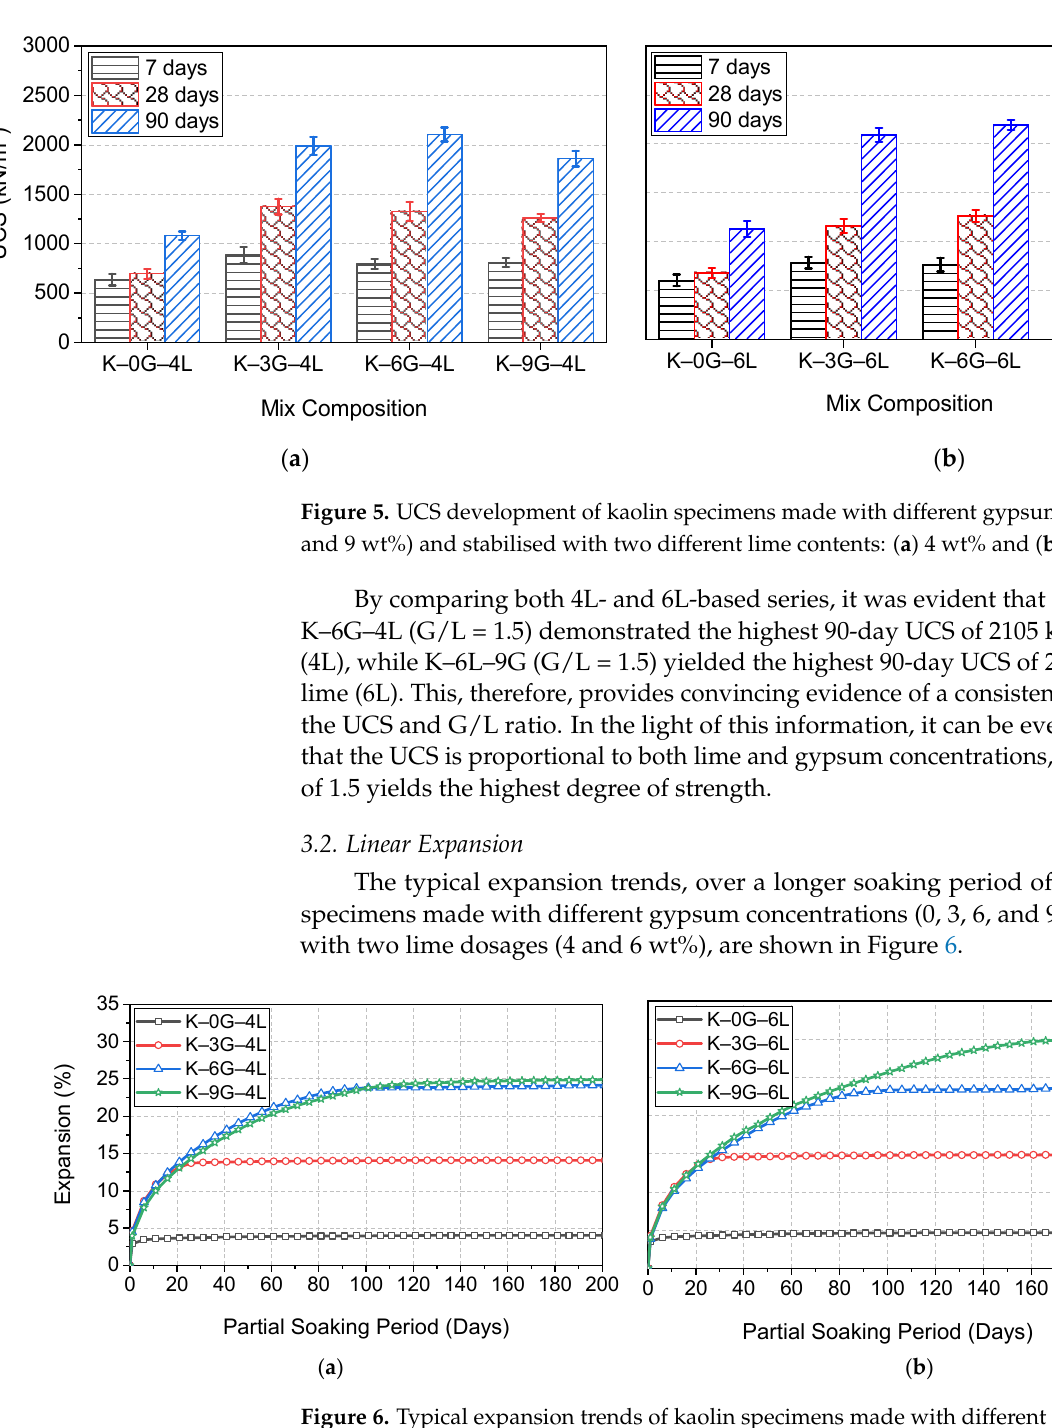
Figure 6. Typical expansion trends of kaolin specimens made with different gypsum concentrations (0, 3, 6, and 9 wt%) and stabilised with two different lime contents: ( a ) 4 wt% and ( b ) 6 wt%. Like the case of UCS, it was observed that the control formulations (without gypsum) tended to show the lowest expansion during the whole soaking period, reaching an ultimate expansion of 4% for K–0G–4L and 5% for K–0G–6L. This expansion occurred immediately after soaking in water and reached the ultimate magnitude within the first week. However, this expansion trend was not the case in the presence of gypsum, as there was a staggering expansion phenomenon, and this phenomenon was proportional to both the lime and gypsum content. In this context, the expansion (4%) of K–0G–4L was increased gradually to 14, 24.2, and 24.9%, while the expansion (5%) of K–0G–6L was increased to 14.8,